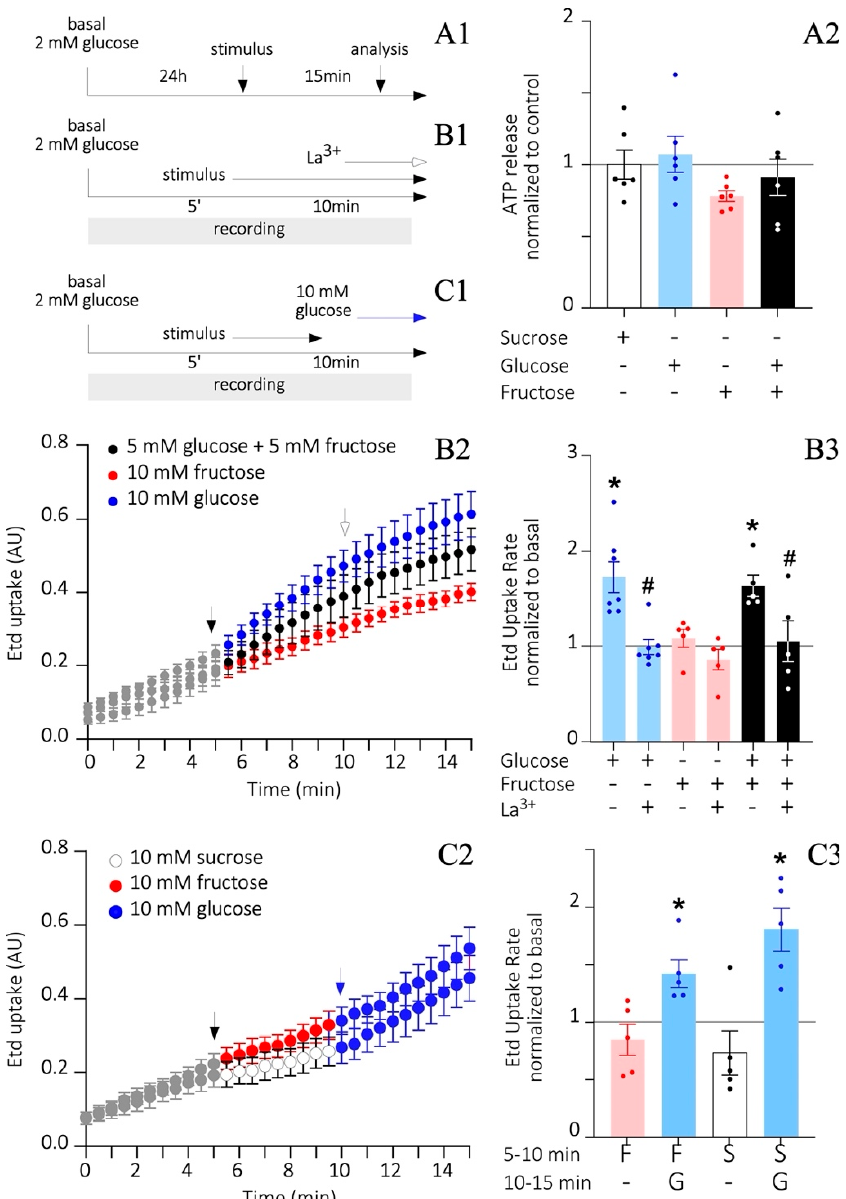
Figure 6. Differential sugar-induced extracellular ATP release and HCs activity in cultured tanycytes. ( A1 – C1 ) A timeline describing the procedures to measure ATP release ( A1 ) and ethidium (Etd+) uptake ( B1 , C1 ). ( A2 ) Luciferin/Luciferase assay to measure the extracellular ATP amount according to the total protein content and normalized to the sucrose condition. n = at least 2 independent cultures per condition. One-way ANOVA with Tukey posthoc. ( B , C ) Etd+ uptake through time ( B2 , C2 ) and Etd+ uptake rate ( B3 , C3 ) after exposing tanycytes to different treatments and quantified as arbitrary units of emitted nuclear fluorescence (AU) over time (min). Data in ( B2,C2 ) represent the average of different experimental n . The black arrows in ( B2 , C2 ) indicate the moment when the stimulus was added. The white arrow in ( B2 ) points to the moment when the connexin HCs inhibitor, Lanthanum ion (La 3+ ), was added. The blue arrow in ( C2 ) defines the time when 10 mM glucose was added. n = at least 10 nuclei per culture and 2 independent cultures per condition were analyzed. One-way ANOVA with Bonferroni post-hoc, (*) p < 0.01. T -test (#) p < 0.05).